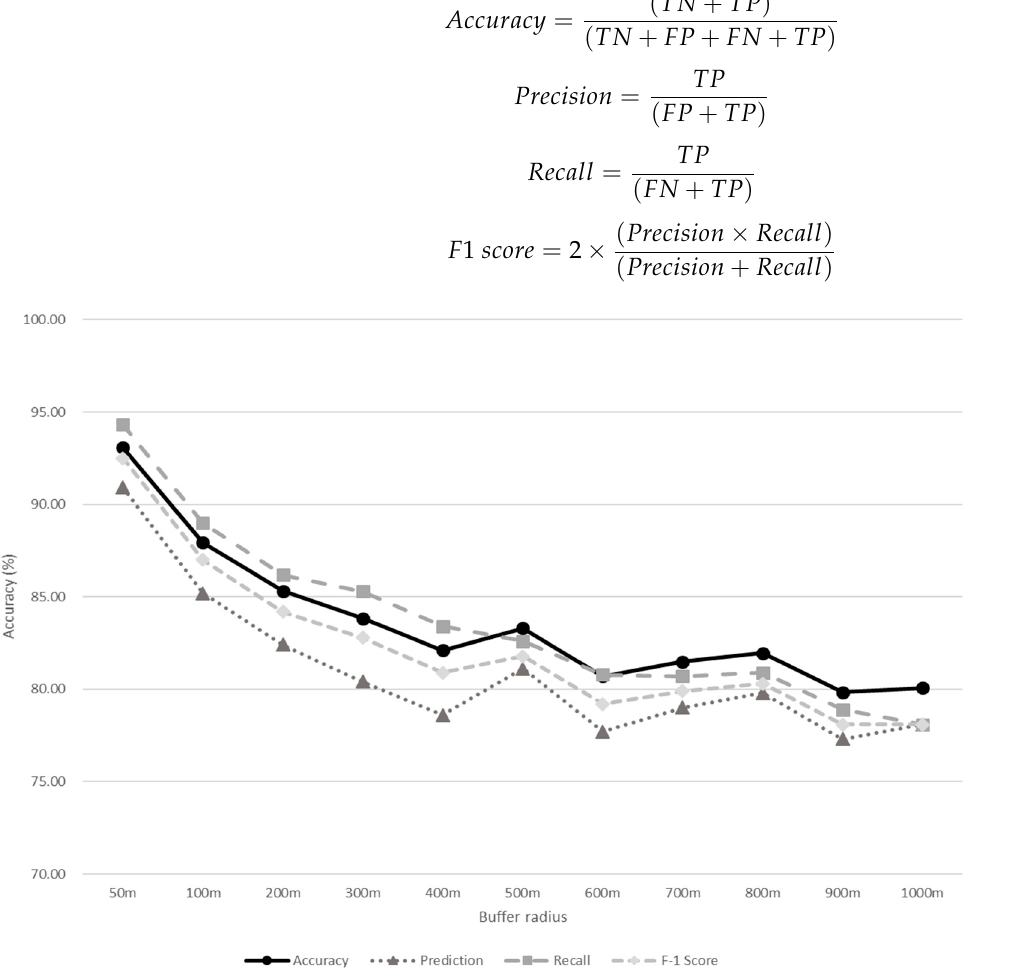
Figure 6. Sensitivity of XGBoost model accuracy by buffer radius (50~1000 m).